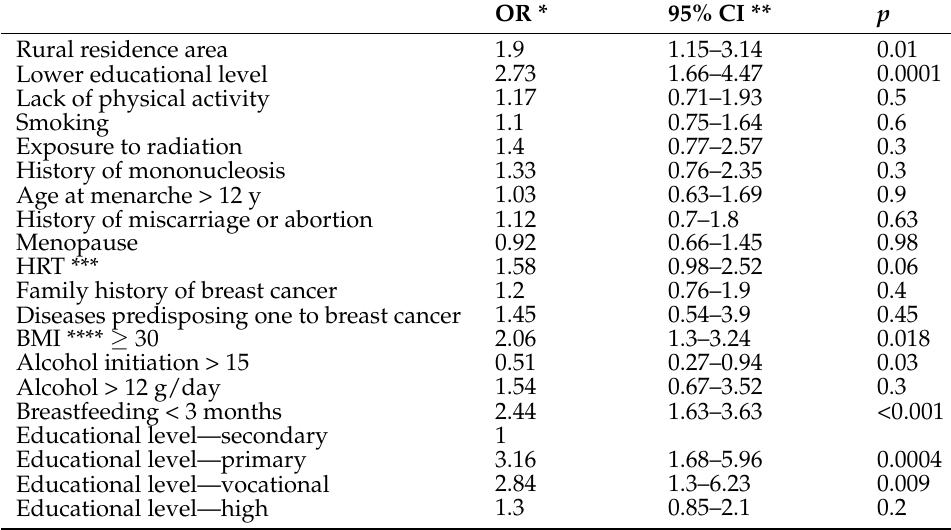
Table 2. Results of univariate logistic regression.